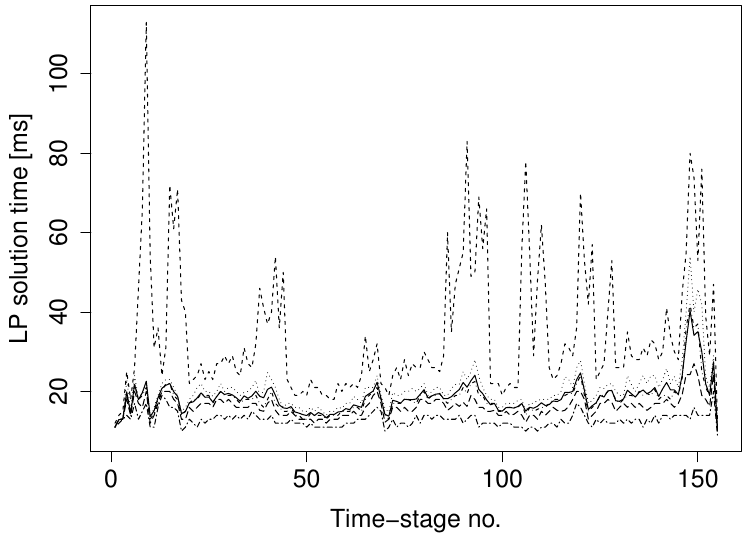
Figure 4. LP solution times (in milliseconds) per time stage in the backward iteration. The curves represent the 0, 25, 50, 75 and 100